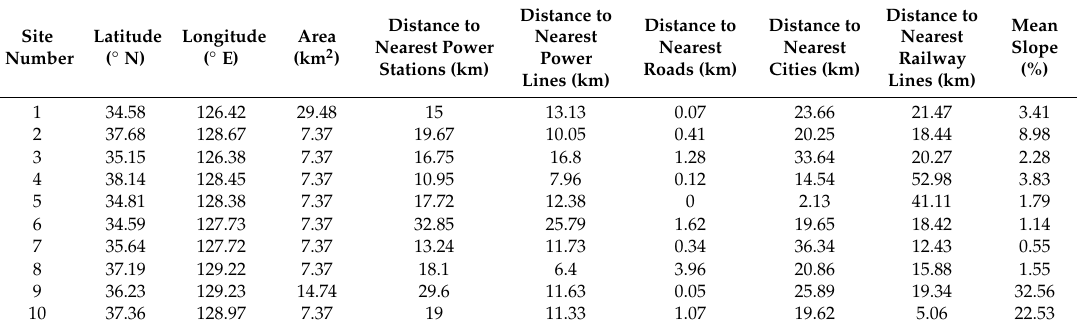
Table 2. Geographical details of proposed onshore wind farm sites [22].